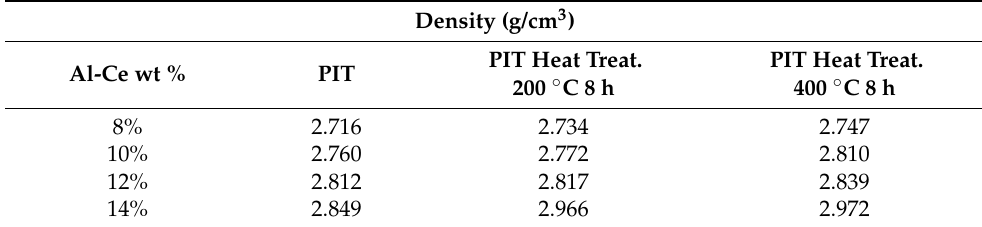
Table 3. Density Al-xCe via PIT before and after heat treatment.